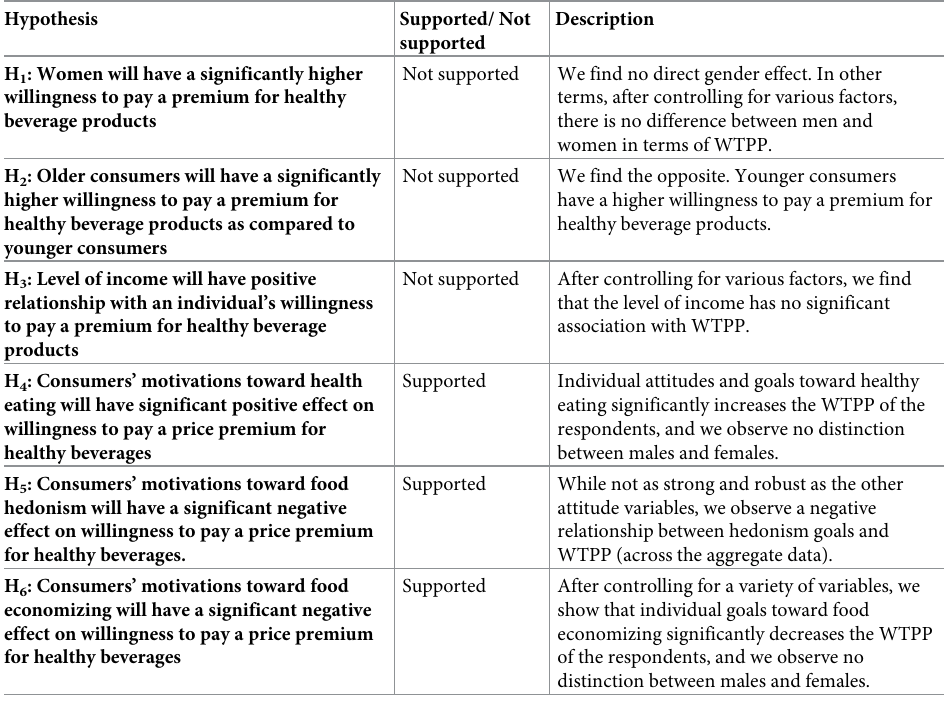
Table 6. Hypotheses test